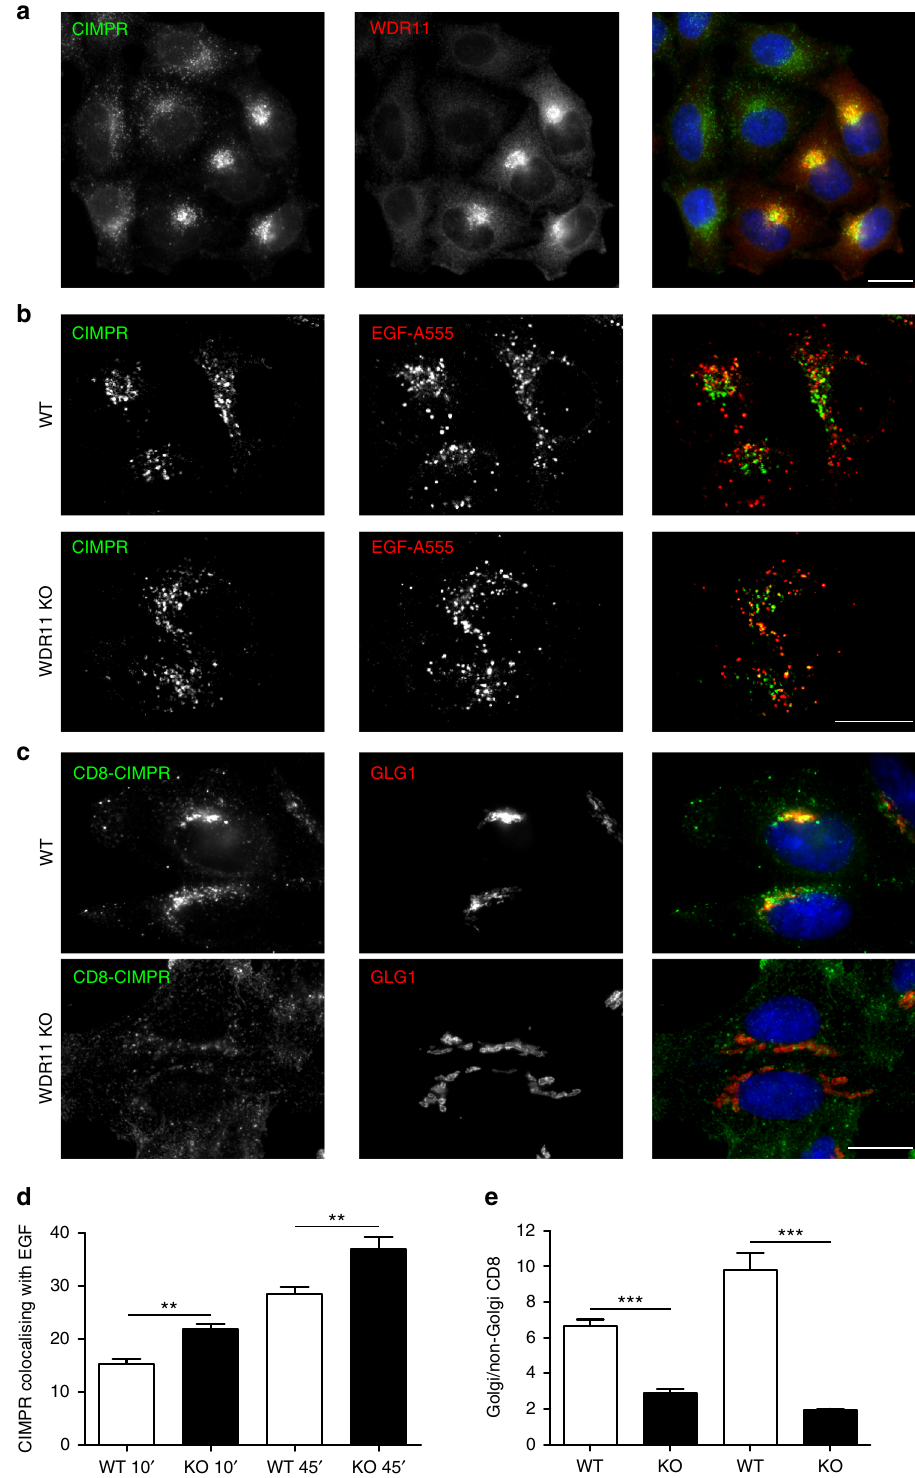
endosomes. Together, these observations point to a role for the WDR11 complex in the traf fi cking of AP-1-dependent cargo proteins from early and/or recycling endosomes to the TGN. BioID identi fi es proteins in proximity to the WDR11 complex